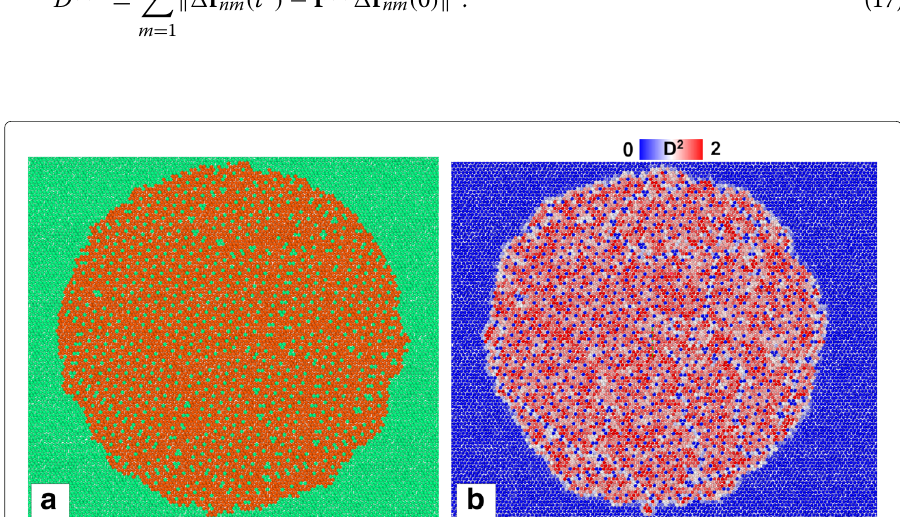
Fig. 14 Atomic structure after the grain shrinkage (θ 0 = 21.8 ◦ ) : a atoms that have not changed their first nearest neighbors shell are represented in green; b atoms are colored according to the value of the D ( n ) 2 coefficient (see text for